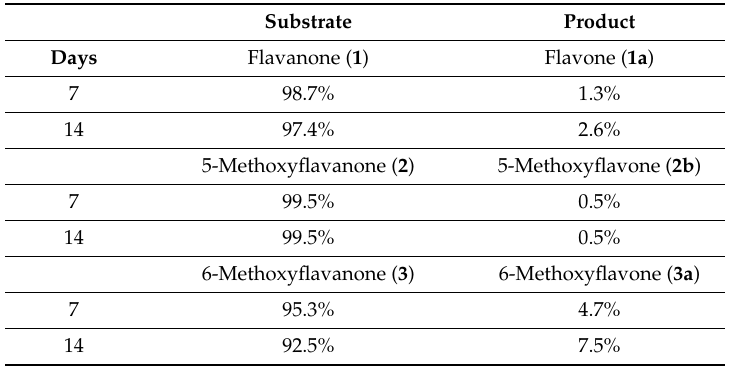
Table 2. Percentage of substrates and biotransformation products in G. max water cultures.